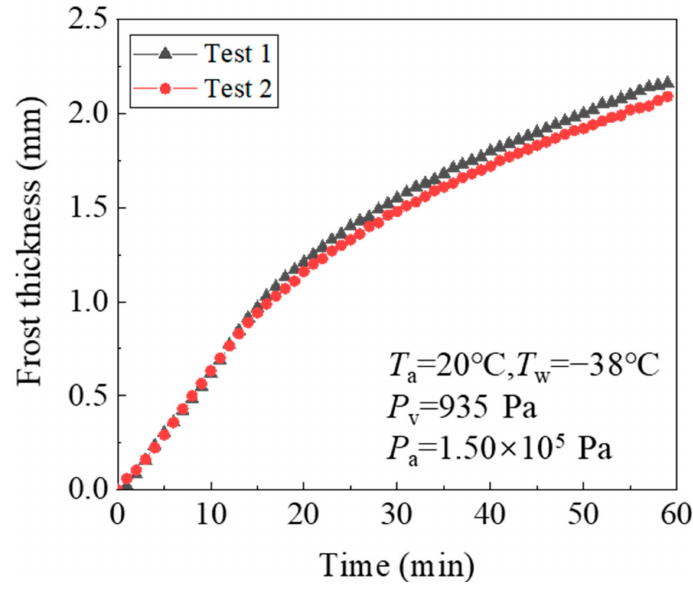
Figure 4. Frost thickness during the repeatability tests.